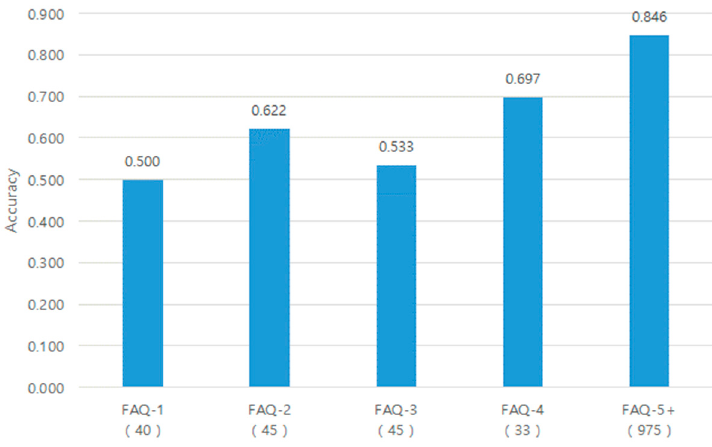
Figure 7. Performance changes according to the size of training data. “5+” means five or more.